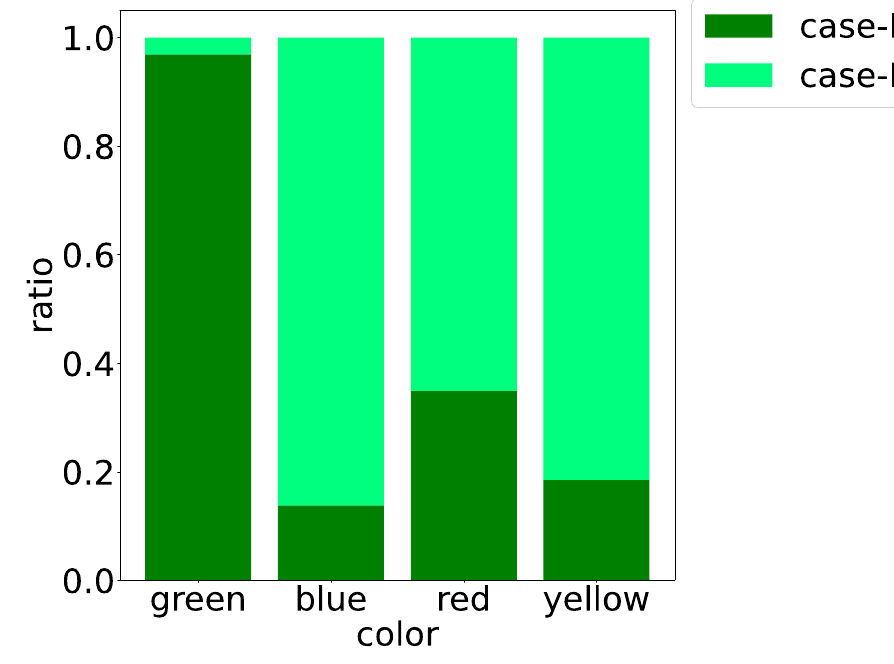
Figure 15. Ratio of case I to case II for each color.